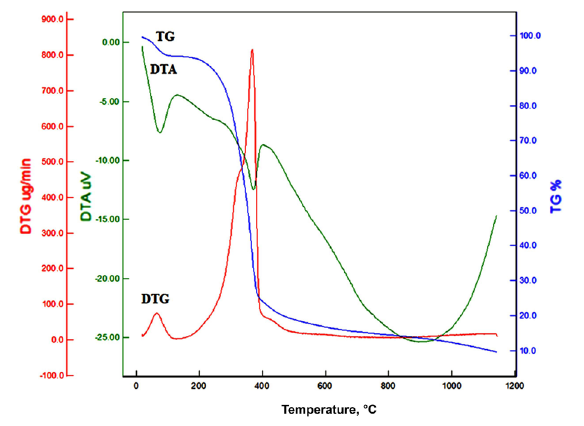
Fig. 5. Thermogravimetric curves (TG, DTA, DTG) of pine wood